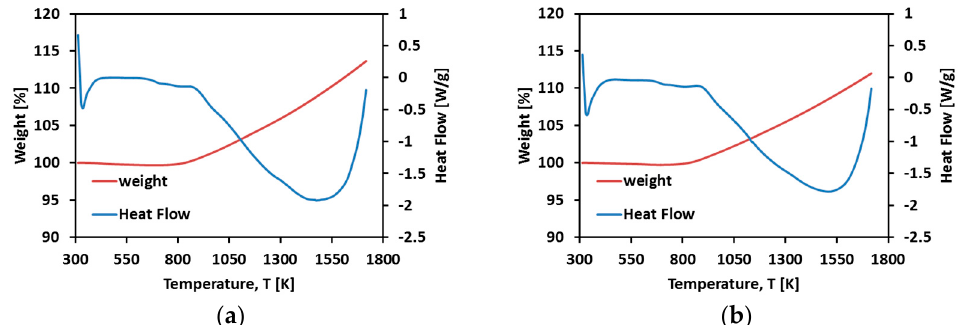
Figure 1. TGA-DSC curves of ( a ) 150 μ m TNZT powder and ( b ) 300 μ m TNZT powder.